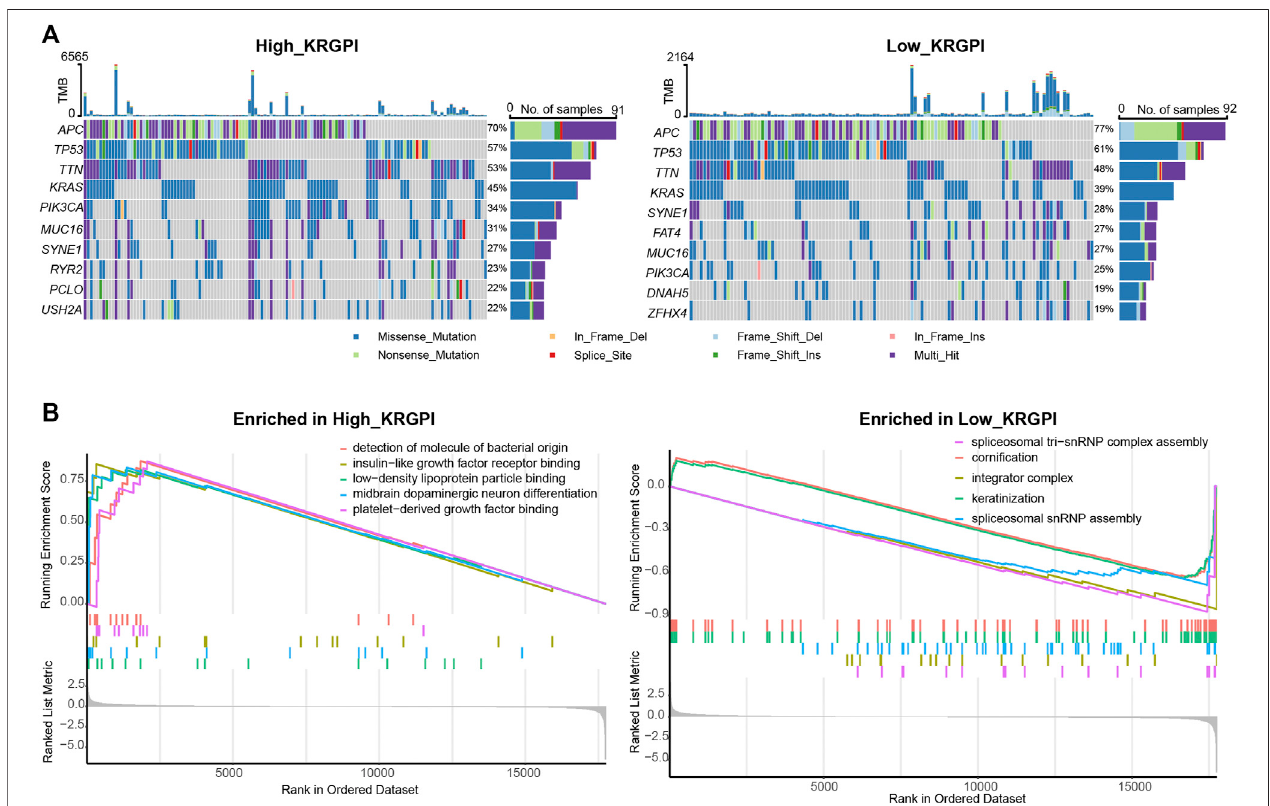
FIGURE 5 | Molecular characteristics of KRGPS subgroups. (A) Top 10 mutated genes in KRGPS subgroups. (B) Top 5 pathways enriched in different KRGPS subgroups by GO analysis ( p < 0.05).